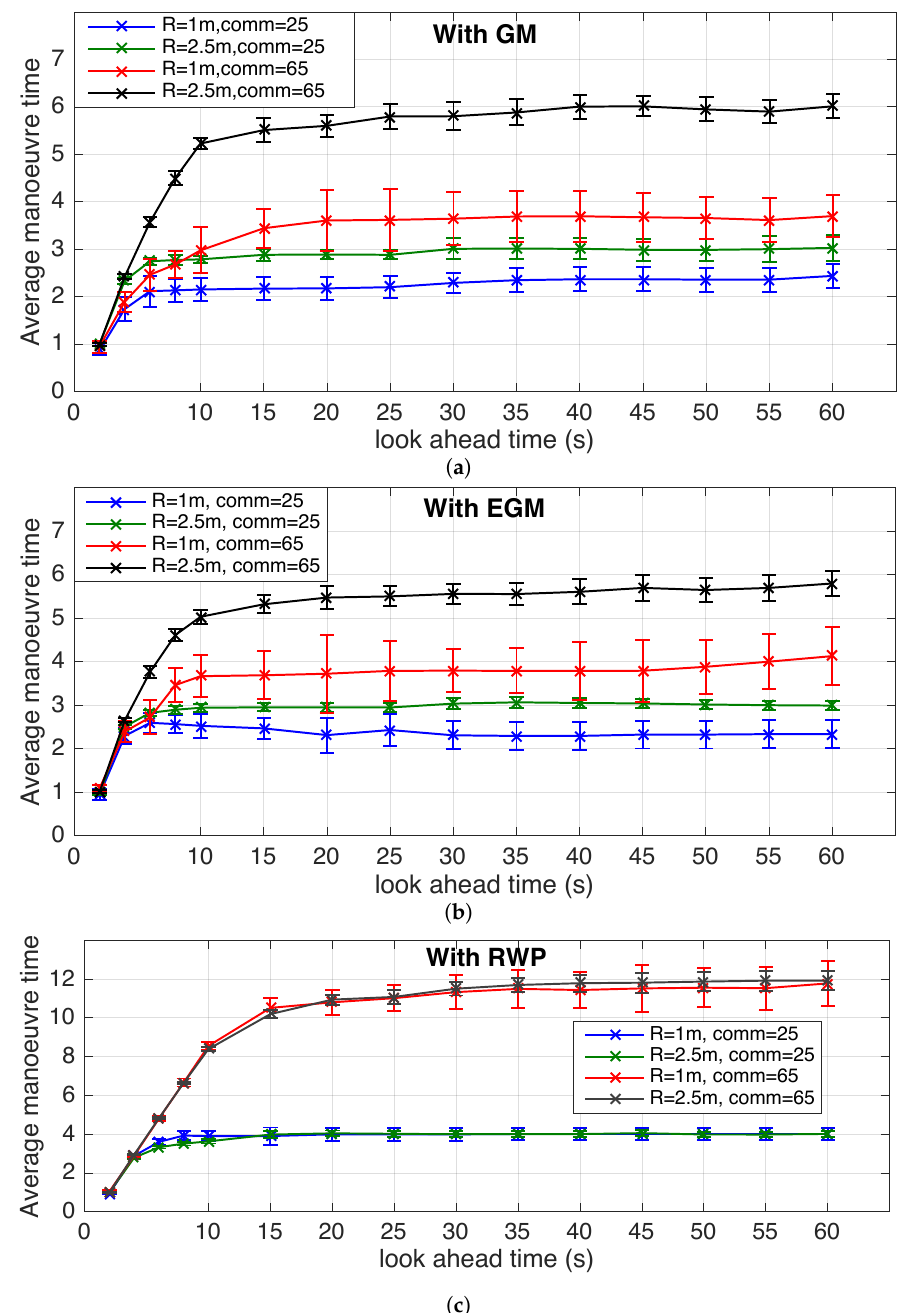
Figure 11. Average maneuver time under different T l , σ , and R using ( a ) GM; ( b ) EGM; ( c ) RWP. If the σ is 25 m and the speed is 3 m/s, and assuming two drones enter each other’s range and head to each other, this will give 8 s until the collision. Such conflict cannot be predicted before that. Therefore, a minimum of 8 s for look ahead is required in this case ( σ = 25 and speed = 3) to detect such conflicts. However, we should avoid larger look ahead values with nonlinear mobility as they will negatively impact undetected conflicts and false alarms. Using GM and EGM, the drones will change their heading at each step (the considered time step (update interval) for both GM and EGM is 0.5 s), and the actual position in the near future may differ from the expected position by SLIDE. Figure 12 shows a sample of a GM path and compares it with the expected straight line path for 60 s. The distance between them reaches 7 m after 39